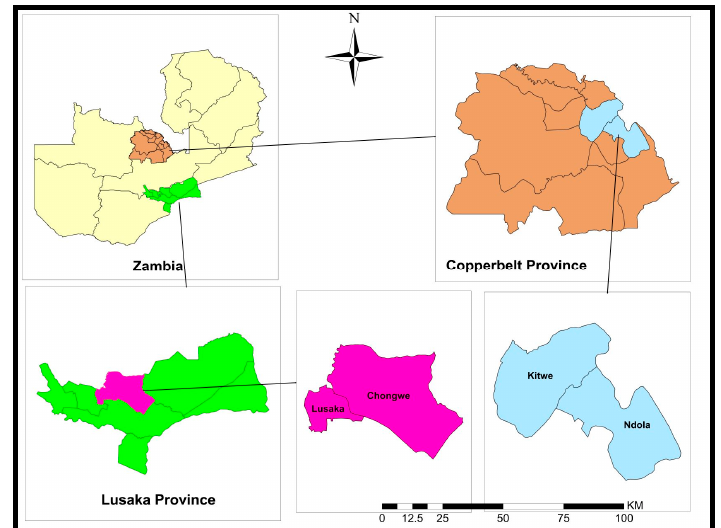
Figure 2. Map of the study areas.